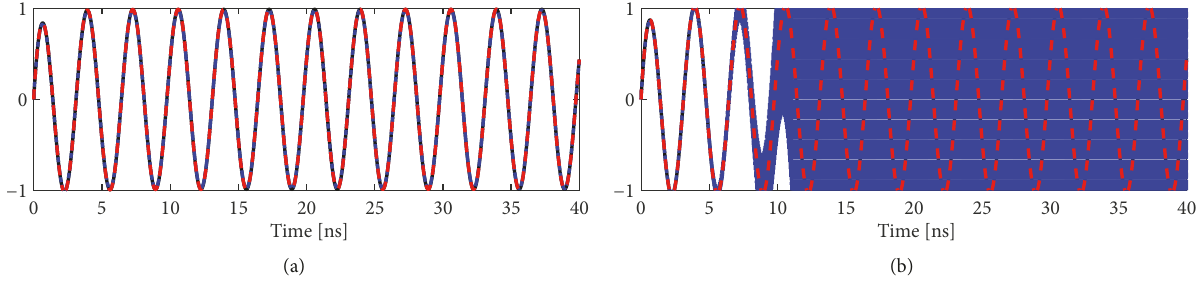
Figure 2: 1D FDTDsimulations for differentsets of modified Lorentzparameters.(a)All FDTDformulations arestable. (b)Only ADE-FDTD is unstable. Legends are the same as Figure 1.